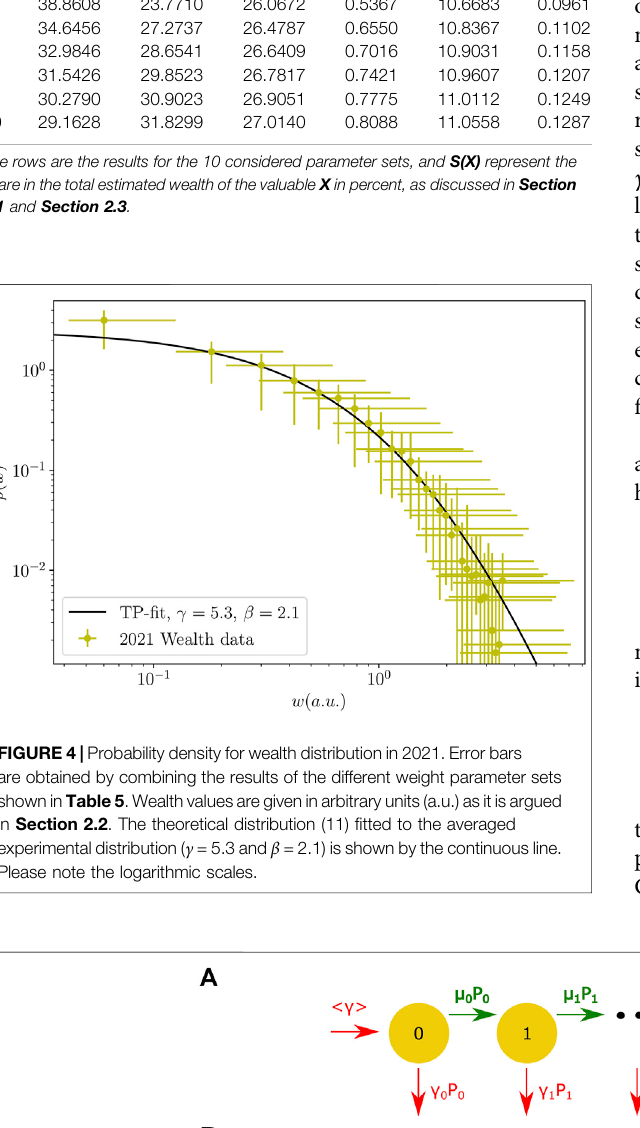
Frontiers in Physics |